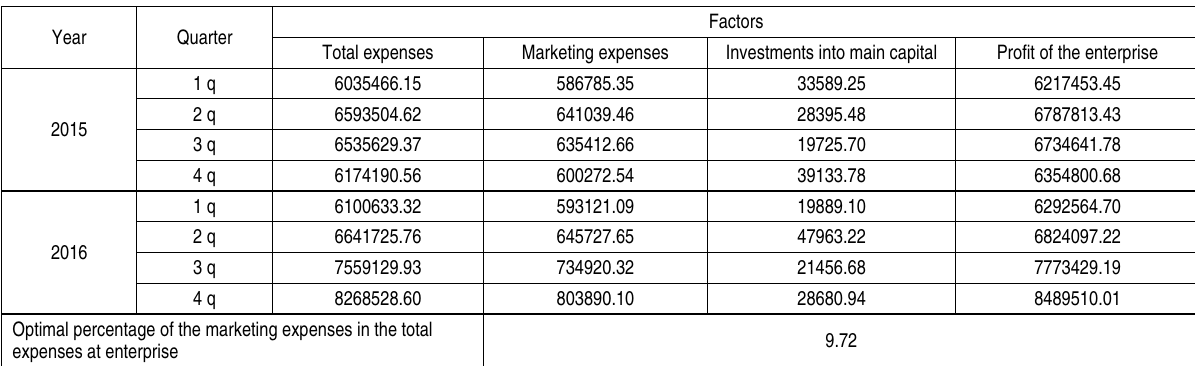
Table 3. Prognosticated values of total expenses, marketing expenses, demand and profit of LLC “Turbomash” during 2015-2016 within quarters,